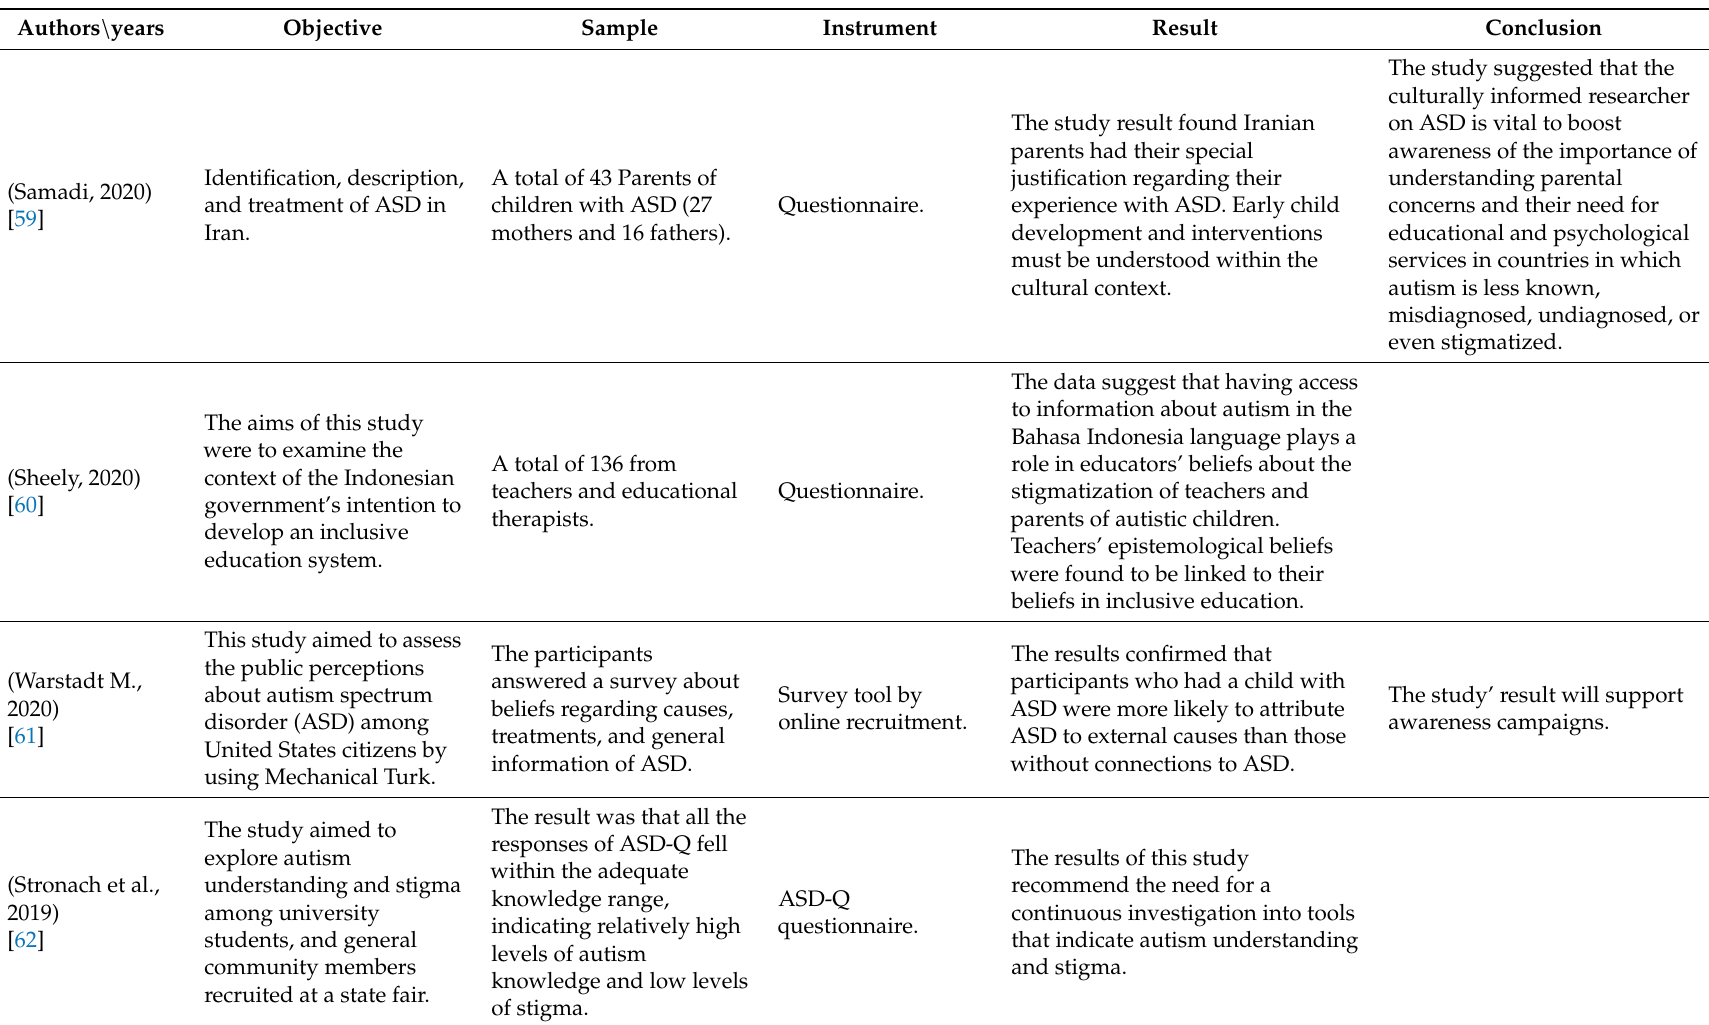
Table 2. Summary studies of beliefs about